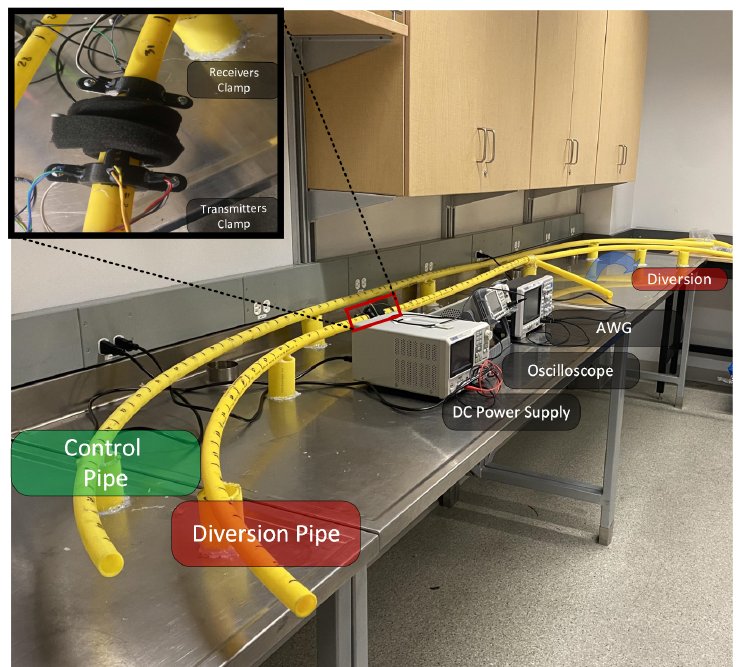
Figure 1. Pipe samples: the pipe on the right has a diversion (tee-fitting), whereas the one on the left does not (control